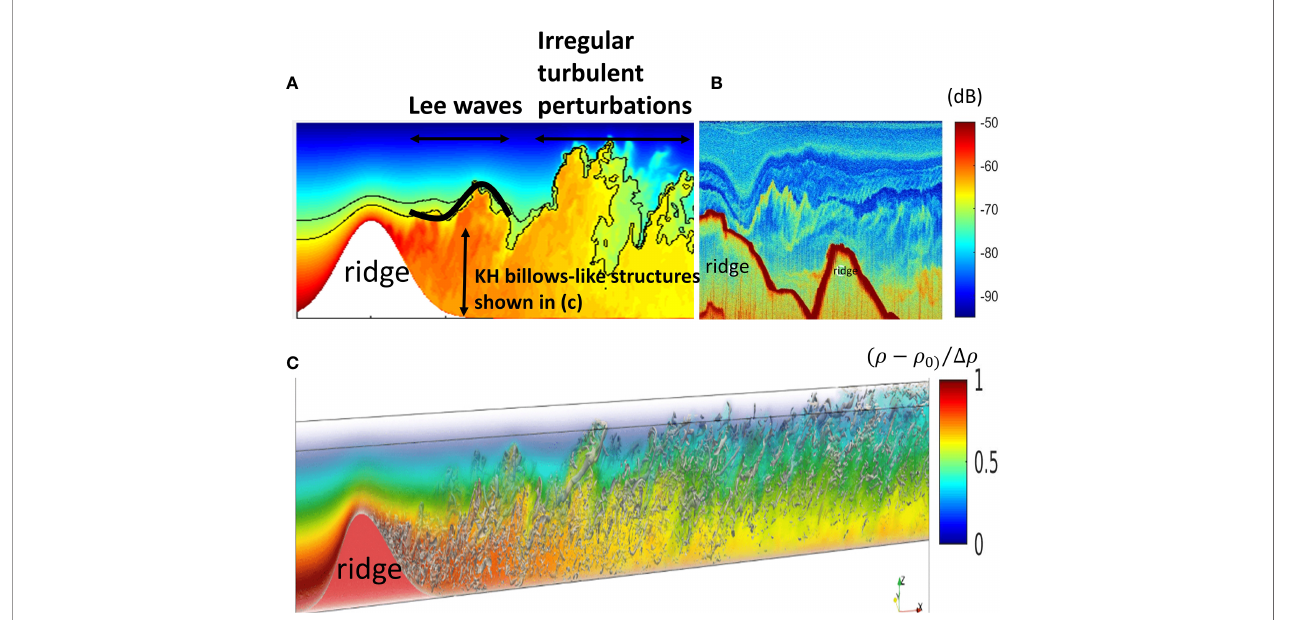
FIGURE 3 | (A) A schematic diagram shows the process of lee wave breaking and irregular turbulent perturbations in the lee of the topographic ridge. The color shows normalized density ( r – r 0 )/ Dr , where Dr is the density difference between the top and bottom boundary and r 0 is the background density [see the color legend in (C) ]. (B) The shipboard observation of echo sounder intensity shows that the occurrence of lee waves and irregular oscillations in the lee of the topographic ridge. (C) Model results of KH billows-like structures. The coherent structures associated with shear instabilities are visualized by Q-method (Jeong and